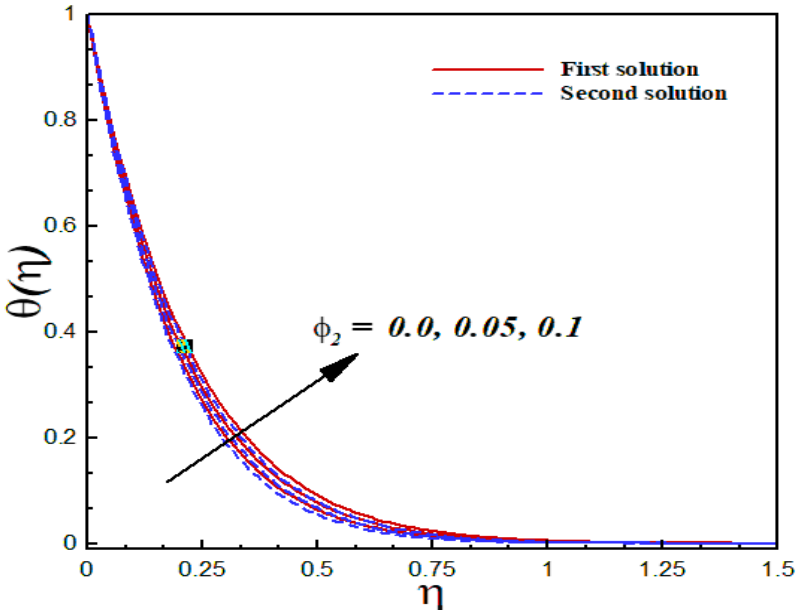
Figure 17. Temperature profiles θ ( η ) for distinct ϕ 2 when λ = − 1.5, k 1 = 1 = γ = s , δ = − 2, ϕ 1 = 0.1, Pr = 6.2.